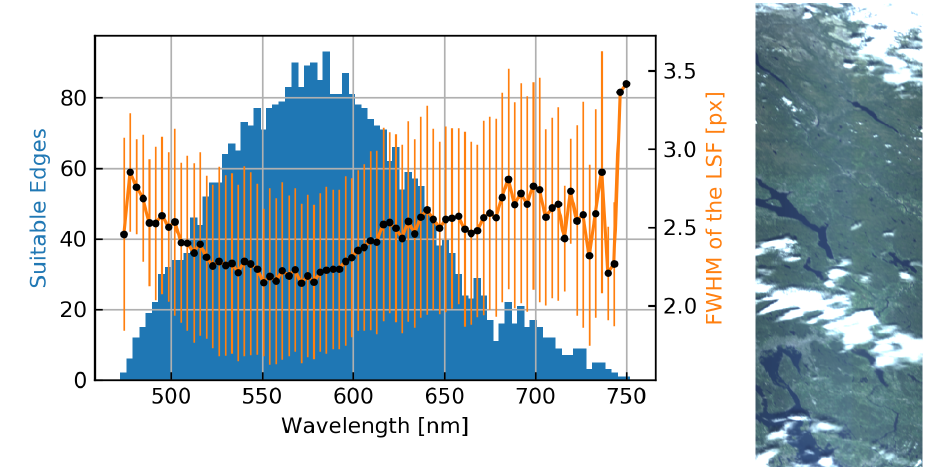
Figure 6. Estimated LSF FWHM (black dots, right axis). The vertical lines indicate the 1 σ -deviation. How many suitable edges used in the estimation per band is indicated by the blue histogram, left axis. An RGB composite of the image used in the sharpness assessment is shown to the